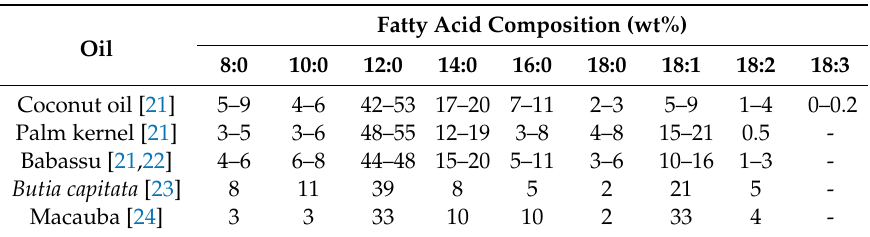
Table 1. Fatty acid profiles of suitable oils for use as feedstocks in medium-chain fatty acid to biojet (MBJ) production.